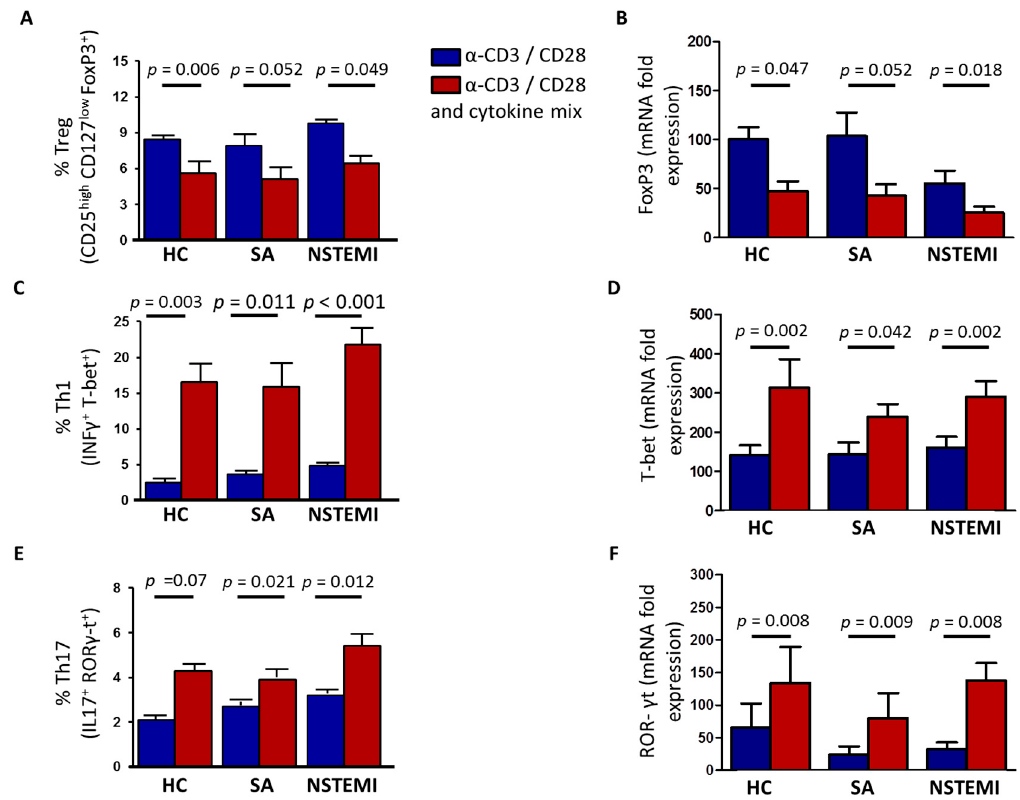
Figure 4. Naïve T-cell differentiation after T-cell receptor (TCR) activation and exposure to cytokine mixture. Naïve CD4 + T-cells were stimulated for six days with anti-CD3/-CD28-coated beads alone (blue histograms) or in presence of a cytokine mixture (red histograms) including IL-2, IL-12, IL-1 β , IL-6, TGF- β , IL-23, IL-10, anti-human-IL-4. The cytokine cocktail reduced the frequency of Treg as assessed by flow-cytometry (panel ( A )) and the expression of Foxp3 lineage specific gene (panel ( B )) and increased the frequency of Th1 and Th17, as assessed by flow-cytometry (panel ( C , E )) and the expression of their lineage specific genes T-bet and Ror γ -t, as assessed by RT-qPCR (panel ( D , F )). No statistical differences were observed among the three groups of study under these experimental conditions. Cumulative data from 10 NSTEMI10 SA and 10 HC are expressed as mean ± SEM. Th1, Th17 and Treg characterization by flow-cytometry has been described in Figure S2.